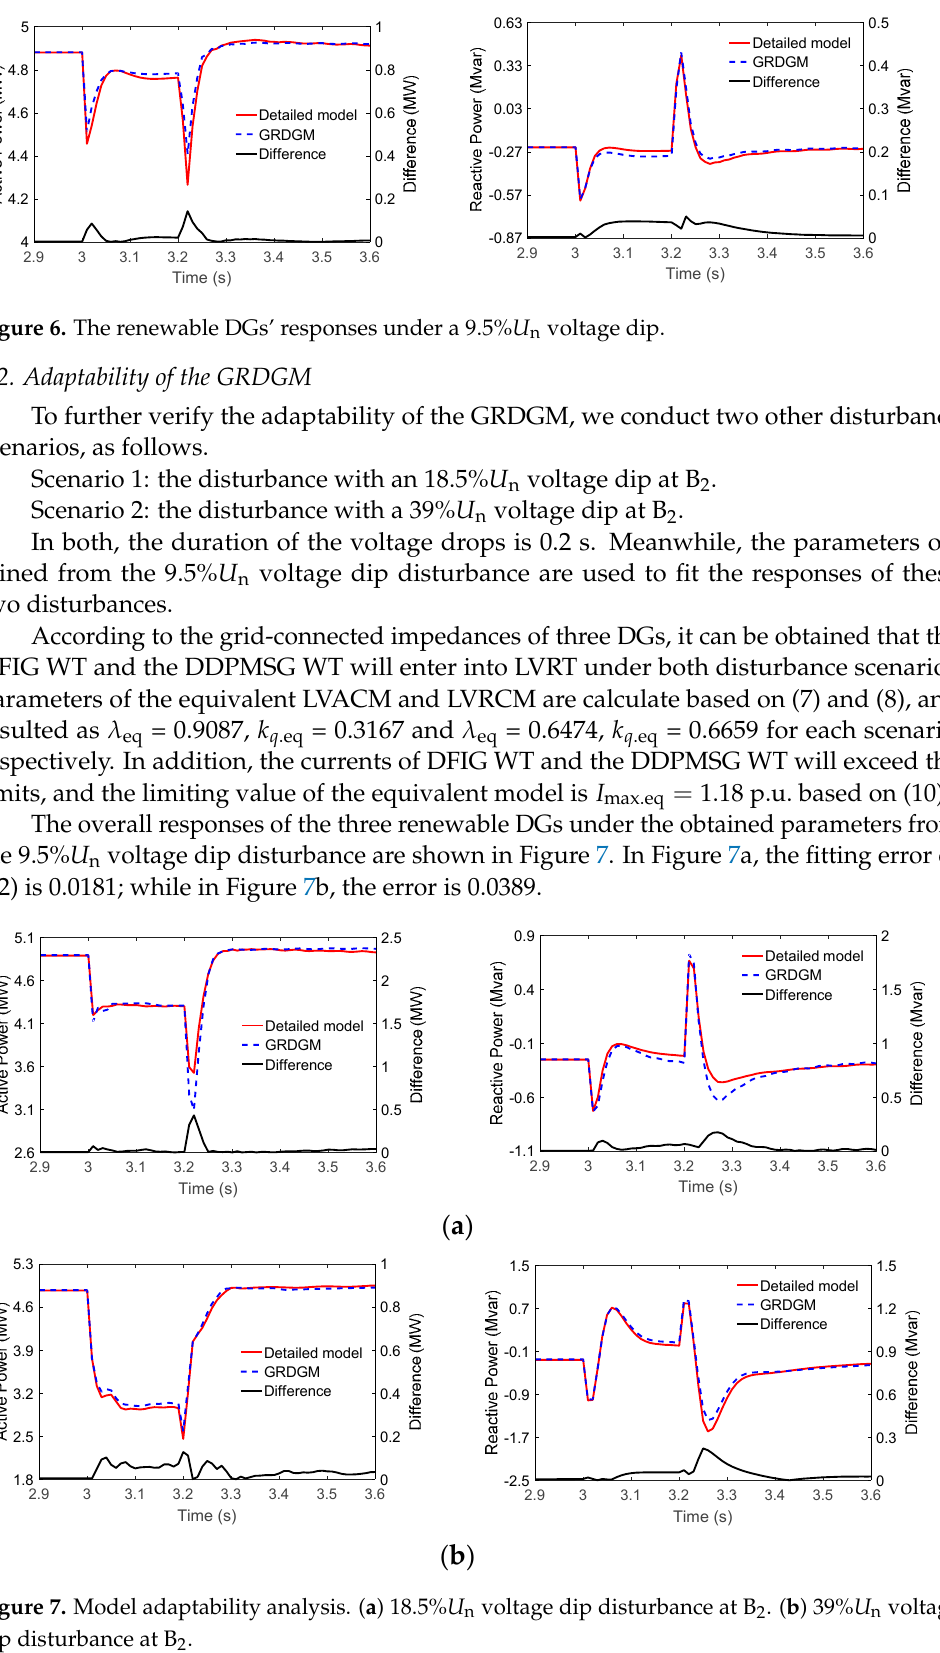
Figure 7. Model adaptability analysis. ( a ) 18.5% U n voltage dip disturbance at B 2 . ( b ) 39% U n voltage dip disturbance at B 2 .